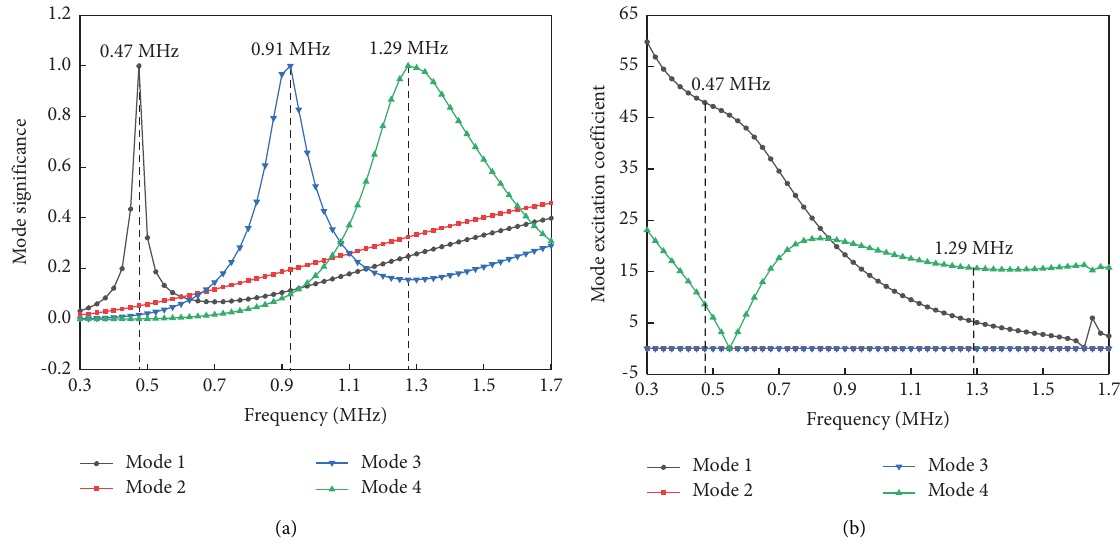
Figure 6: Variation with the frequency of mode signifcances and mode excitation coefcients. (a) Mode signifcances. (b) Mode excitation coefcients.